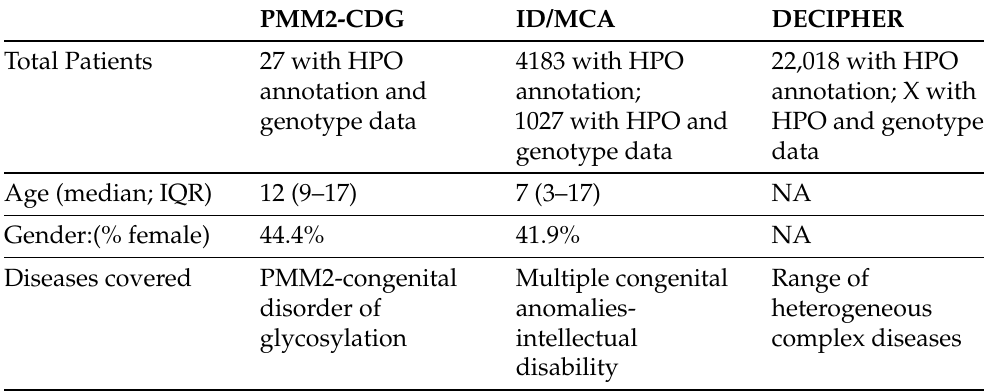
Table 2. General characteristics related to the three datasets used in this study. For the DECIPHER dataset, gender information was not available for the subset of patients used in this analysis, however this information can be viewed for specific patients on the DECIPHER